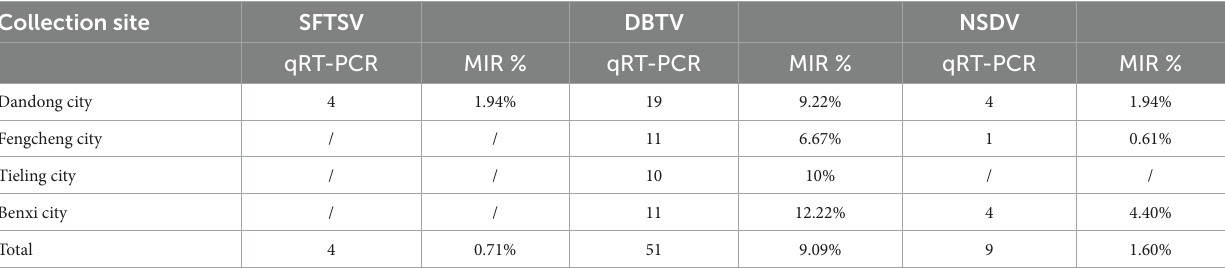
TABLE 1 Positive rates for complete genome viruses collected in Liaoning Province, China. Collection